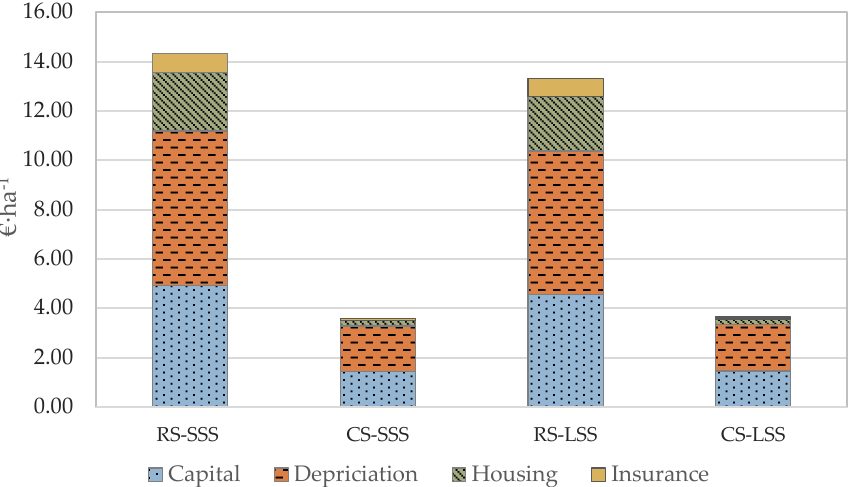
Figure 4. Ownership cost per unit area analysis (RS—Robotic System; CS—Conventional System; SSS—Small-Scale Scenario; LSS—Large-Scale Scenario).